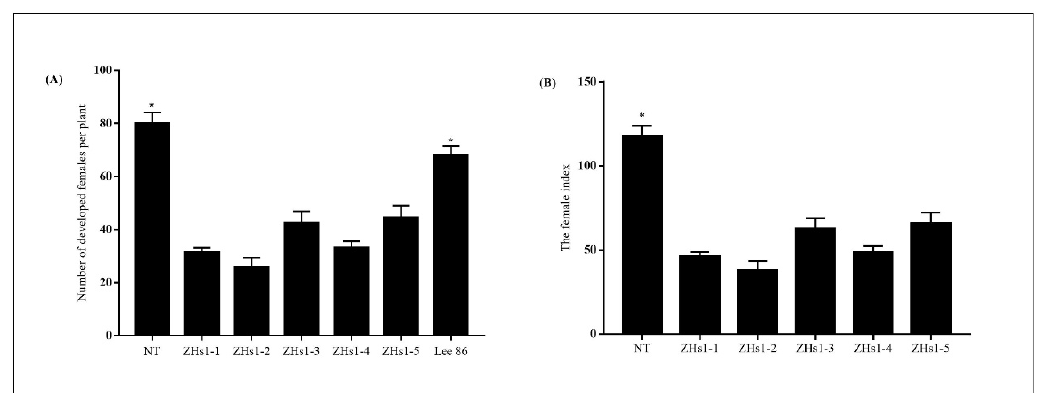
Figure 2. The number of developed females per plant ( A ) and female index ( B ) 35 days after inoculating the SCN race 4 in soybean. NT designates the nontransgenic control ‘ Tianlong 1 ’. Lee 86 is the susceptible cultivar of race 4 of SCN. ZHs1-1, ZHs1-2, ZHs1-3, ZHs1-4, and ZHs1-5 represent the T4 independent transformation events. Bars represent the standard errors of the number of developed females per plant and the female index based on 14 independent plants of each transformation event and controls, including NT and Lee 86. The asterisks indicate significant differences between transformation events and NT at a level of 0.05.